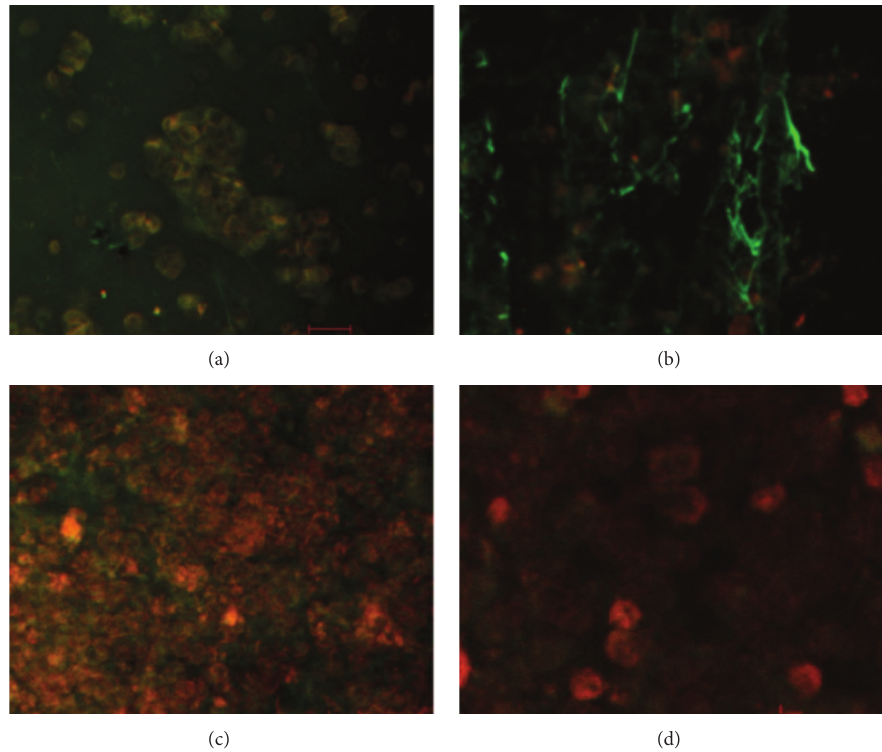
Figure 5: Confocal images for retracted WB clot incubated in pool PPP. (a) showed confocal image of normal retracted WB clot. (b), (c), and (d) showed retracted WB clot after 3, 6, and 9 hrs incubation in pool PPP, respectively. (a) shows confocal images of normal retracted WB clot showing fibrin mass surrounded and covered by RBCs (control untreated). (b) demonstrates a clear separation of fibrin from the RBCs after 3hrs of WB clot incubation in PPP. (c) shows fibrin separation from the RBCs and a gradual loss of fibrin fibres after 6 hrs of incubation. (d) shows at 9 hrs of incubation in PPP minimal fibrin fibres with some remaining